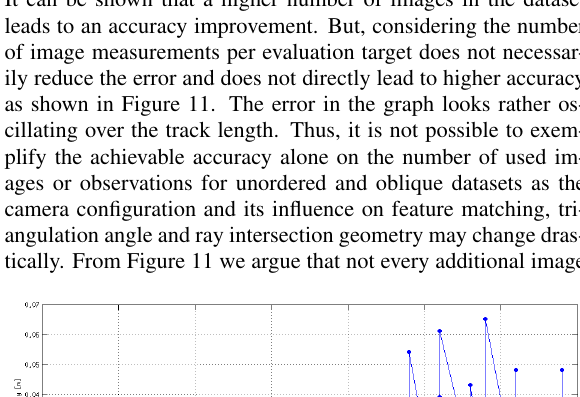
Figure 12: Considering the mean error over all targets, it can be observed, that the mean error increases with larger distances to the object, and with decreasing ground sampling distance, i.e. resolution